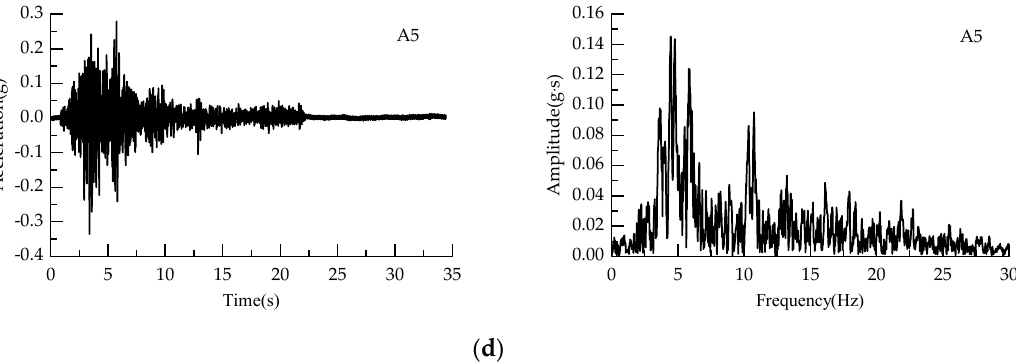
Figure 15. Acceleration records and Fourier spectra of monitoring positions in the shaking table tests. ( a ) Acceleration time history and Fourier spectrum of monitoring point A1; ( b ) acceleration time history and Fourier spectrum of monitoring point A3; ( c ) acceleration time history and Fourier spectrum of monitoring point A4; ( d ) acceleration time history and Fourier spectrum of monitoring point A5.